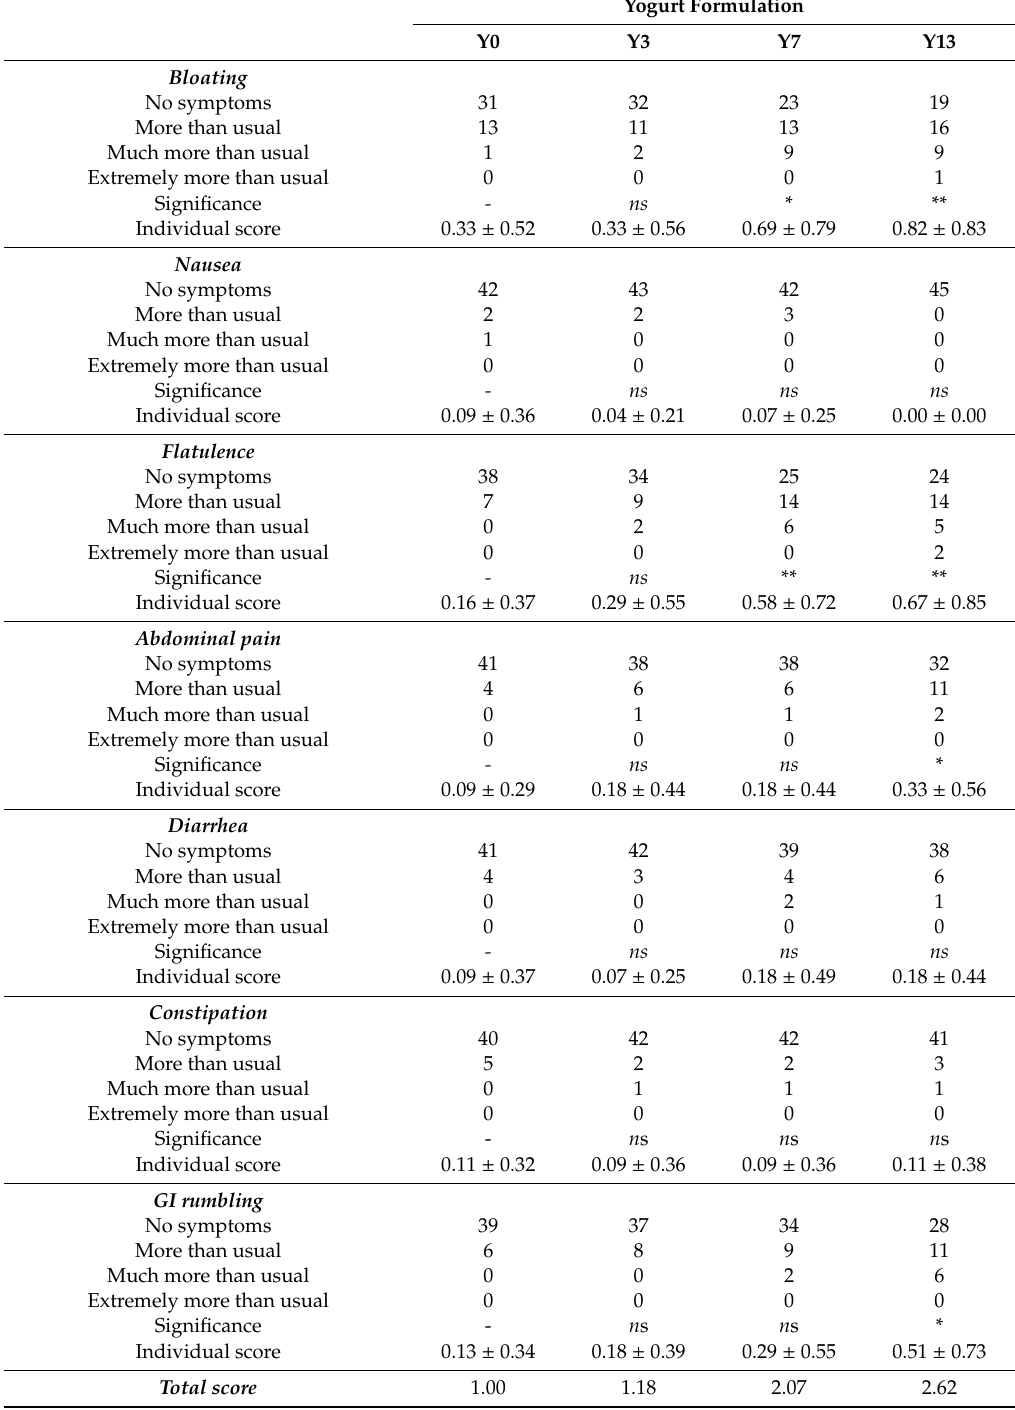
Table 3. Frequency of occurrence and total and individual scores of gastrointestinal symptoms in the 2 and 24 h following consumption of the yogurt treatments in healthy adults ( n =